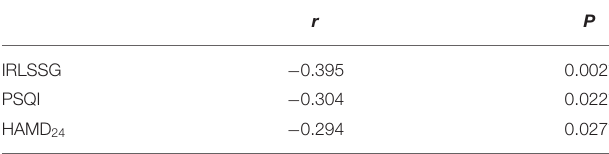
TABLE 5 | Pearson correlation analysis between the VitD level of patients with RLS and various scale